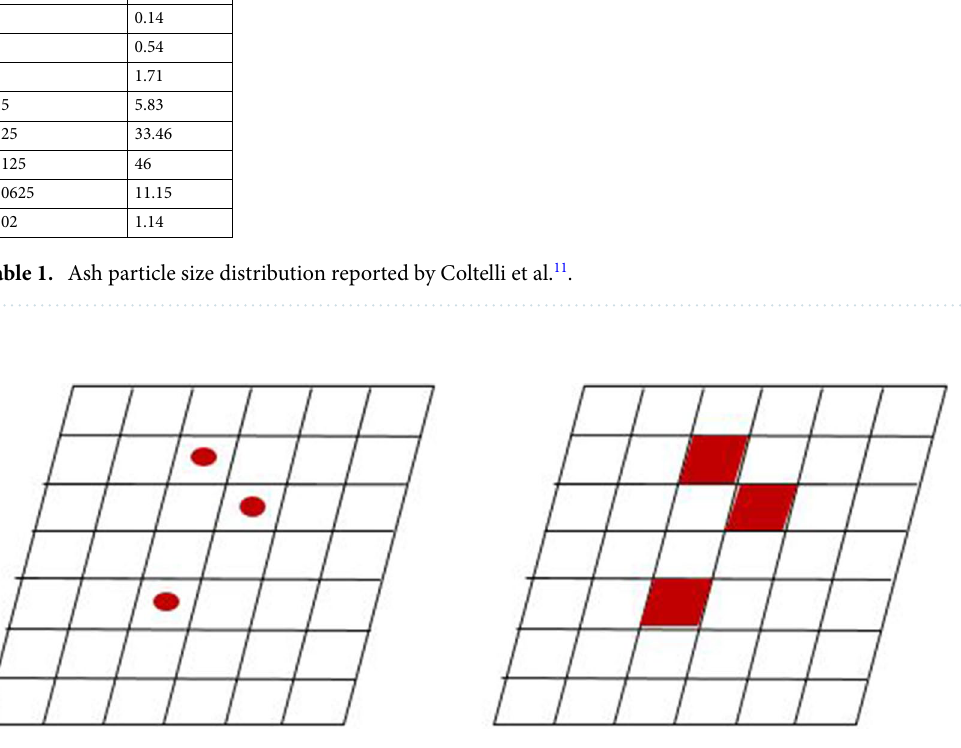
Figure 2. Estimation of particle concentration from the Lagrangian particle tracking method: (Left) Original locations of particles. (Right) Estimated concentration based on grid.